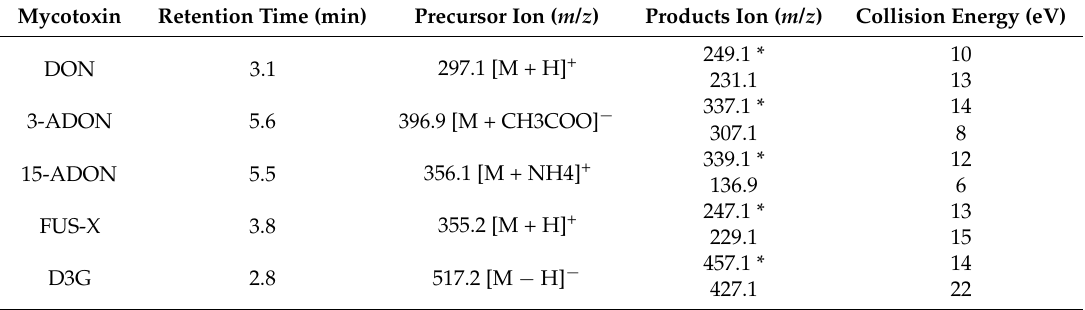
Table 4. MS/MS parameters of the five